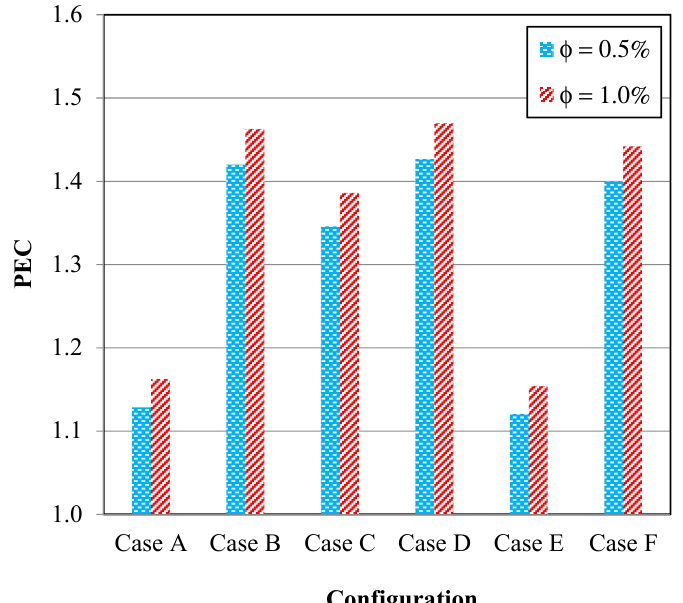
Figure 32. PEC variation for optimum configurations of different cases at Re = 11,000.